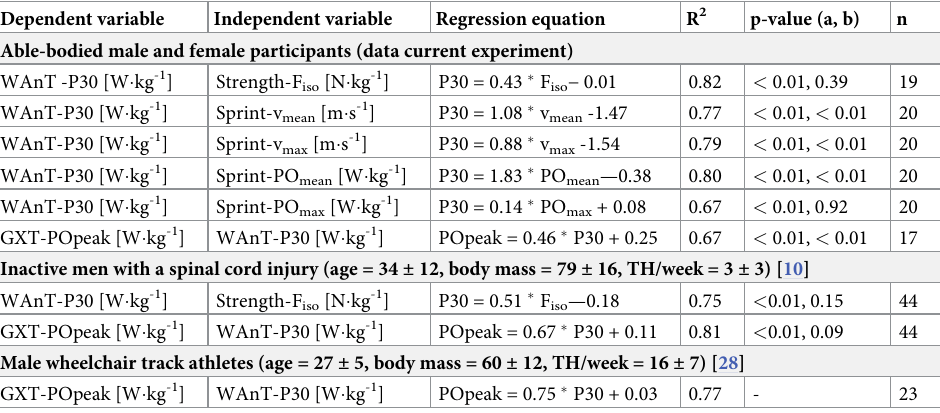
Table 2. Results from the Theil-Sen regression of the current study and from other studies that investigated the same wheelchair-specific